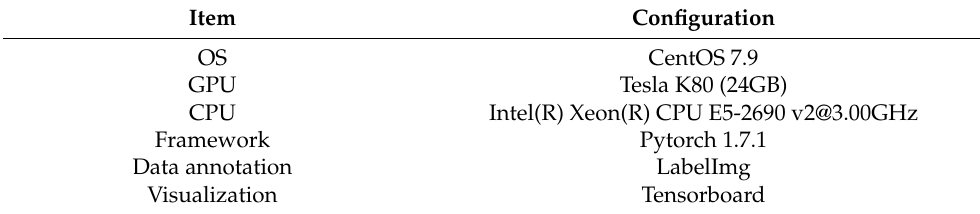
Table 1. Experimental environment